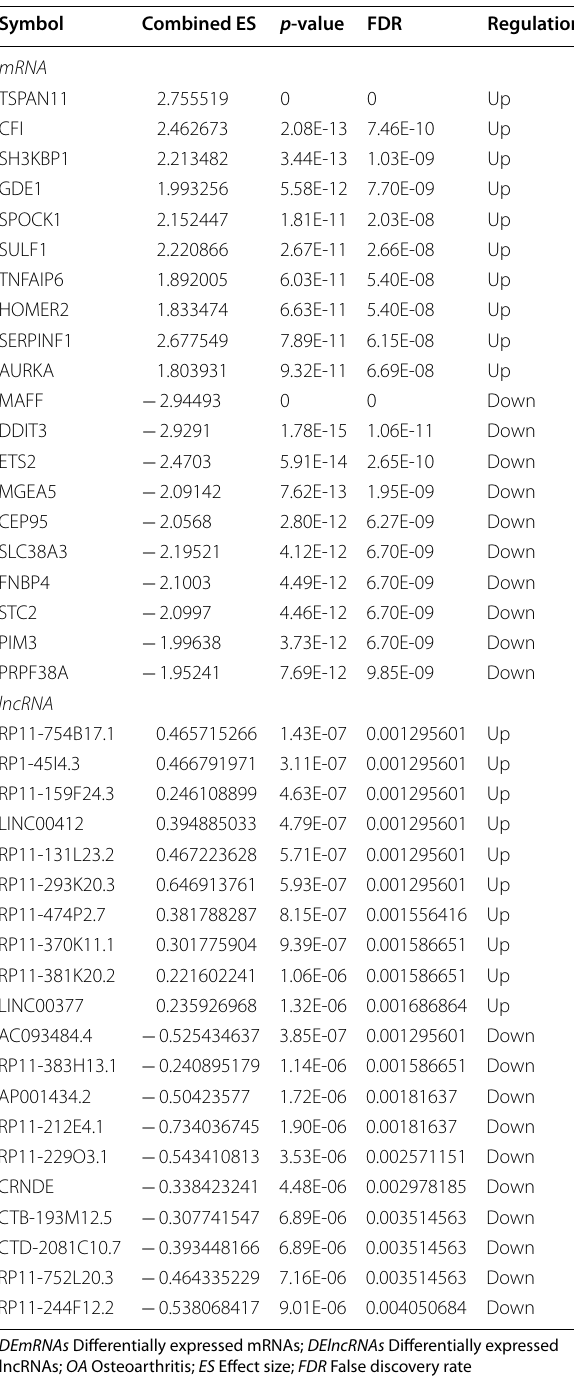
Table 1 Top 10 up- and down-regulated DEmRNAs/DElncRNAs between patients with OA and normal controls